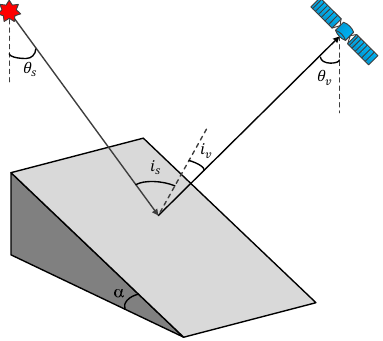
Figure 3. Configuration of solar illumination and sensor over a slope surface.